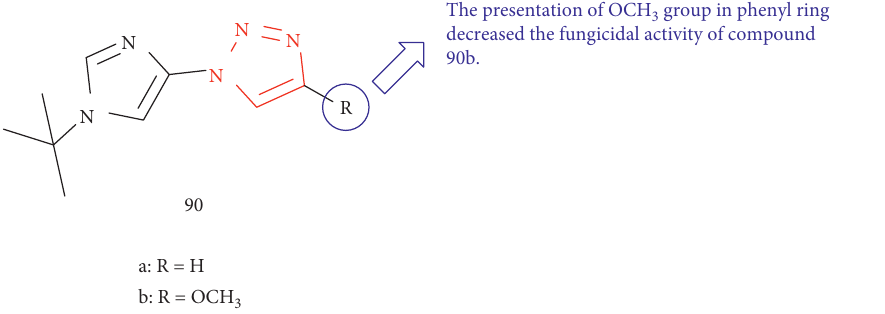
Figure 40: Chemical structure of substituted 1-(1H-imidazole-4-yl)-1H-1,2,3-triazoles.